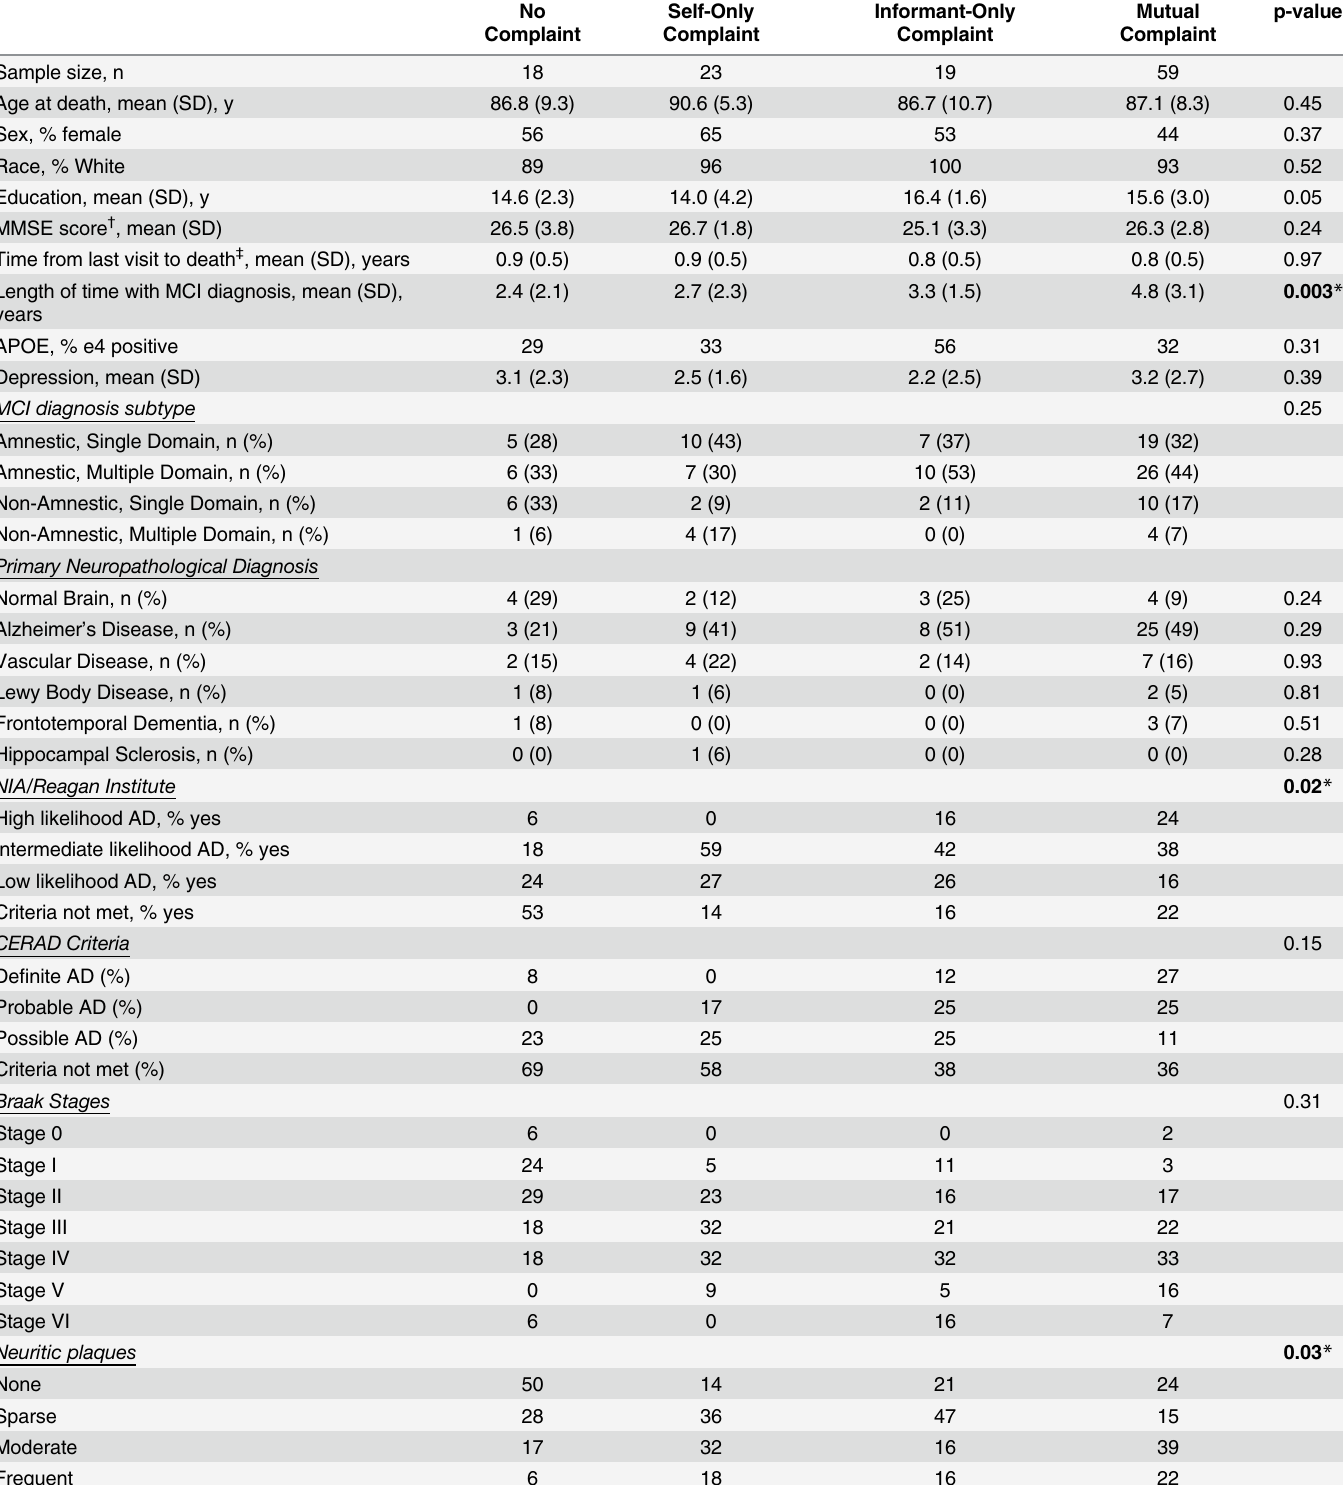
Table 1. Participant Characteristics by Cognitive Complaint